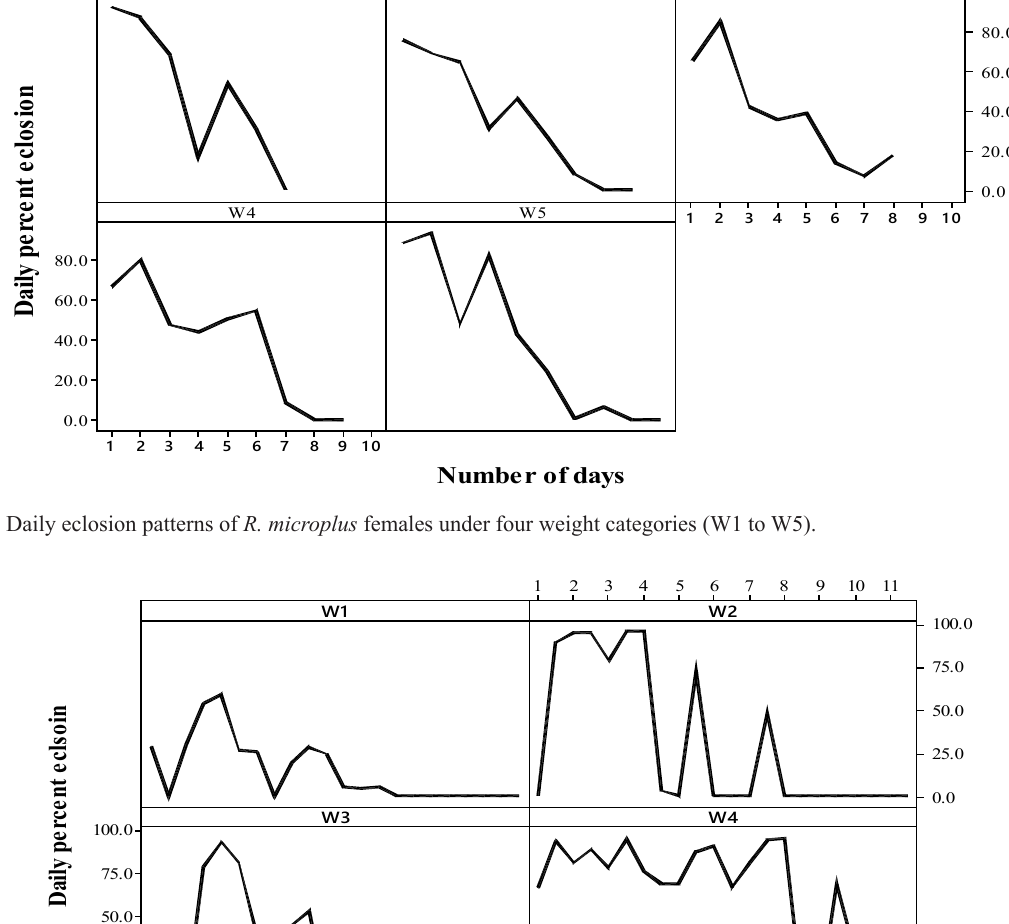
down (Figure 1). On the contrary, the daily eclosion of five weight categories did not have a generalized pattern (Figure 2). However, the eggs laid during the early days of